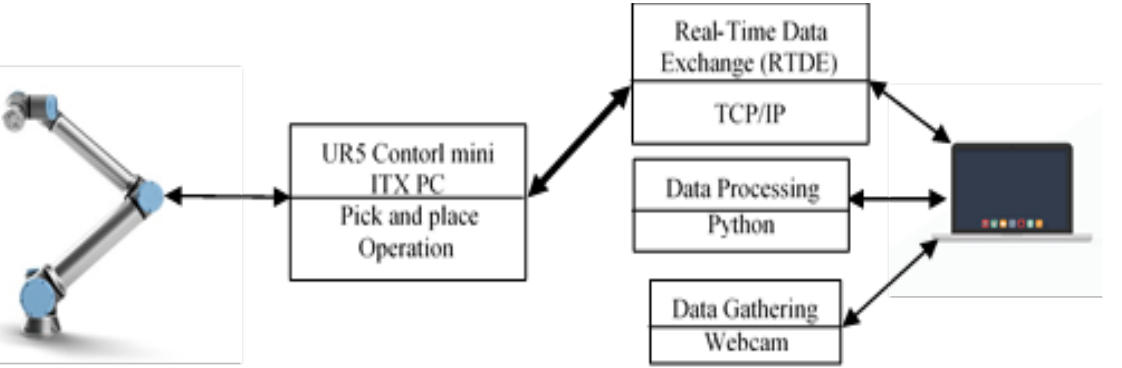
Figure 6. Actuation system capable of implementing control actions. Framework involves laptop computer (computing system), cable for socket communication (follows TCP/IP standards), and UR5 robot.